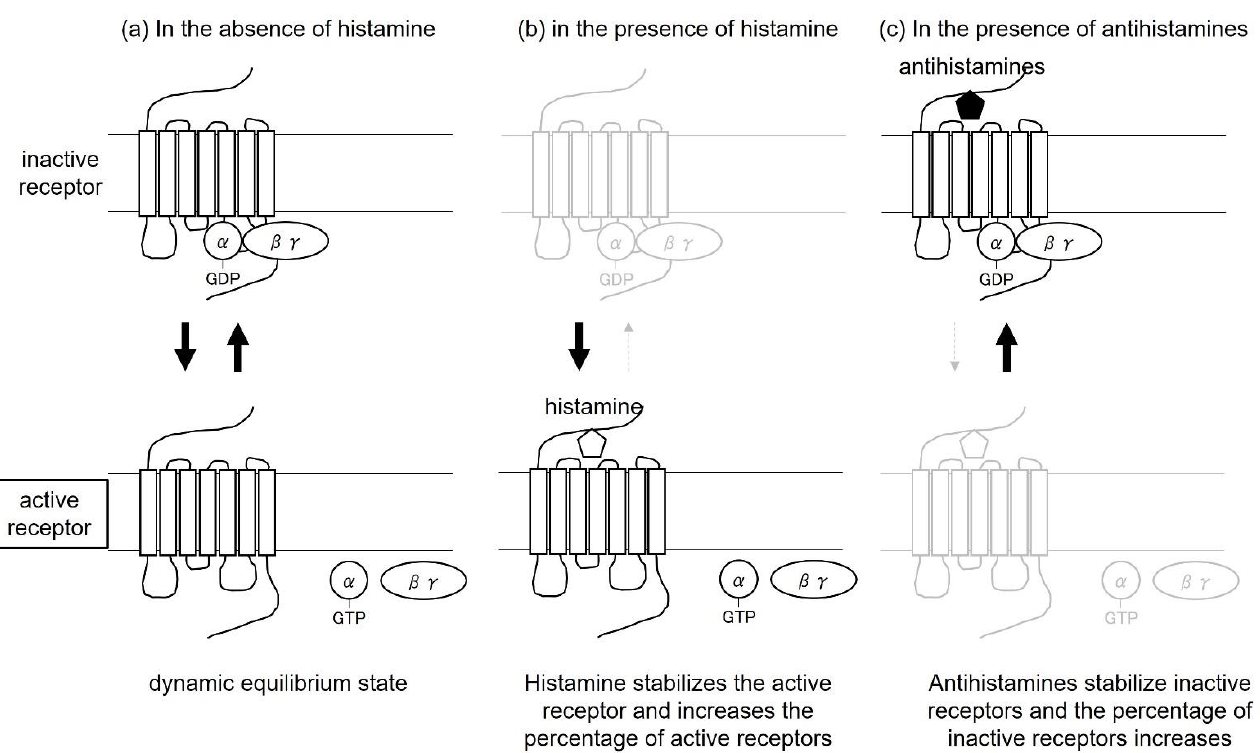
Figure 3. Inverse agonist concept. ( a ) In the absence of histamine, inactive and active receptors are in dynamic equilibrium. ( b ) In the presence of histamine, histamine stabilizes active receptors and increases the percentage of active receptors. ( c ) In the presence of antihistamines, antihistamines stabilize inactive receptors and increase the proportion of inactive receptors.